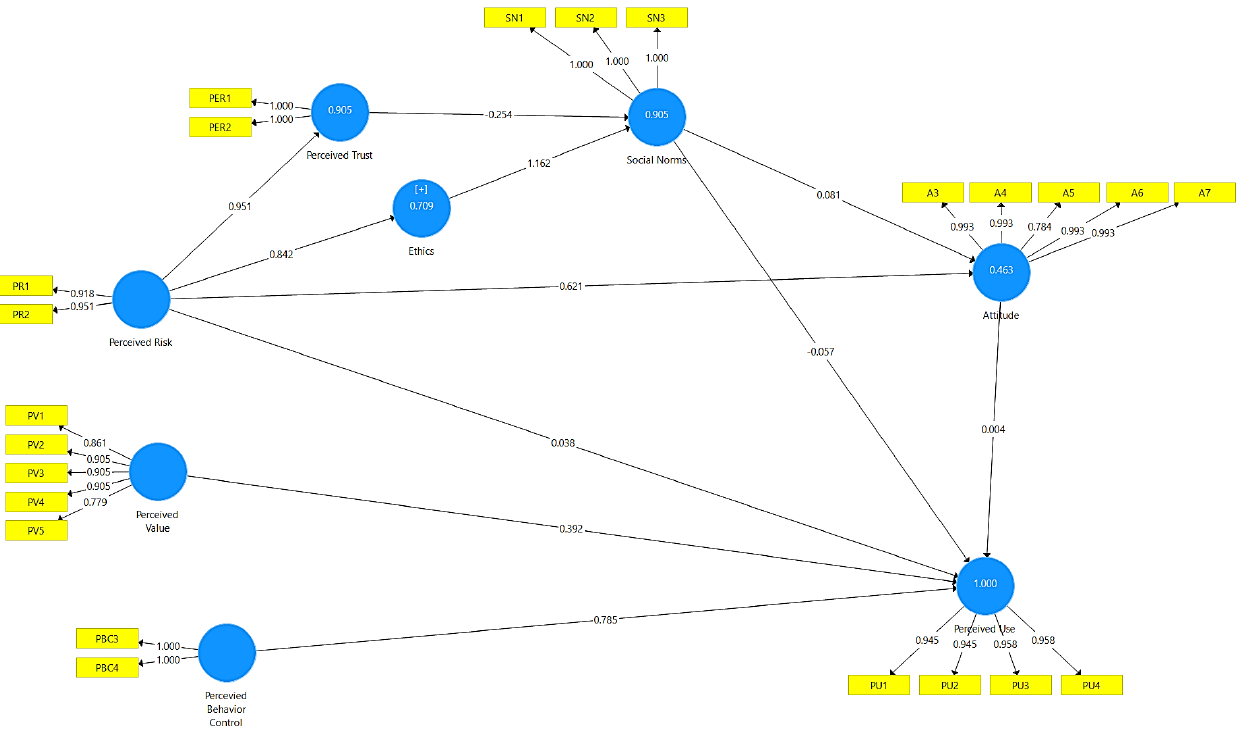
Figure 2. PLS-SEM Model